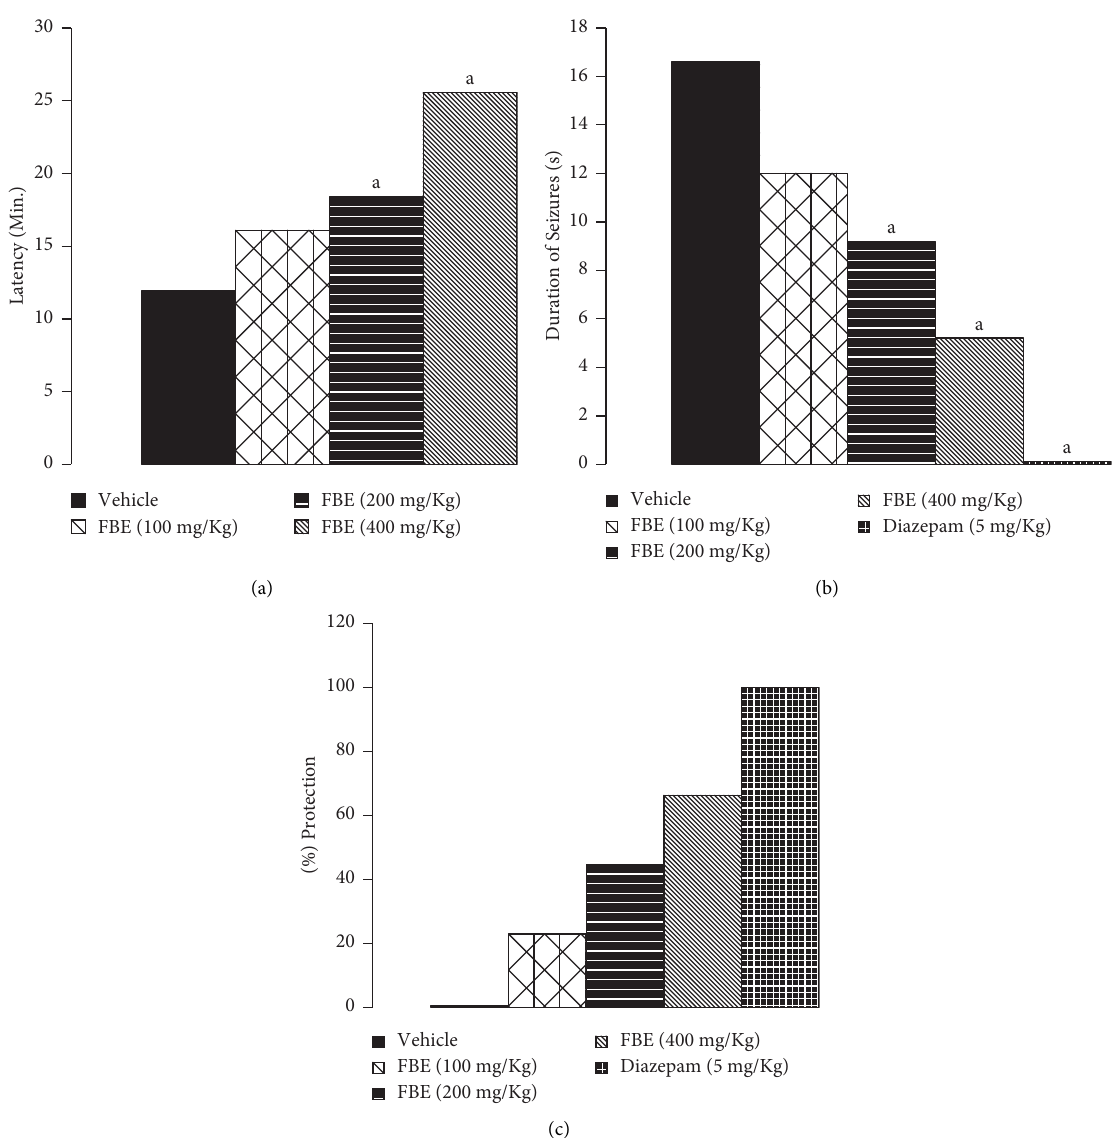
Figure 4: Efect of various pharmacological interventions on picrotoxin-induced seizures. (a) Latency to convulsions, (b) duration of convulsions, and (c) % protection. All values are expressed as the mean ± SEM. a p < 0 . 001 compared to the vehicle